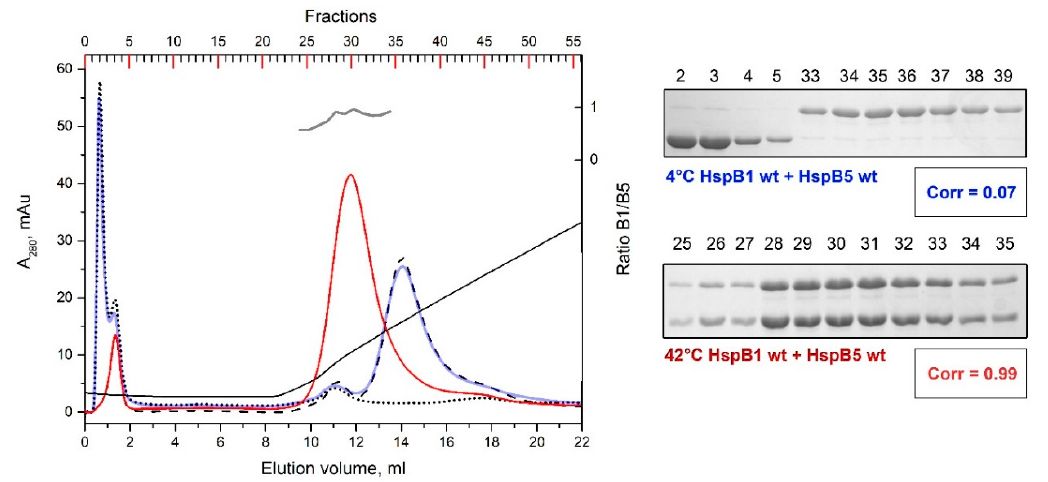
Figure 8. Ion-exchange chromatography of the WT HspB1 and HspB5. The elution profile of isolated HspB1 and HspB5 are shown as black dashed and dotted lines, respectively. The elution profile of the mixture of HspB1 and HspB5 preincubated at low temperature is shown as a solid blue line and that of the corresponding mixture preincubated at elevated temperature is shown as a solid red line. The molar ratio HspB1/HspB5 (grey solid line) in corresponding fractions obtained after chromatography of preheated sample is indicated on the right ordinate. Conductivity is shown as a solid black line. The protein compositions of fractions obtained after chromatography of HspB1/HspB5 mixture preincubated at low (labeled blue) or high (labeled red) temperature are presented on inserts. Correlation coefficient (Corr) is indicated under each electropherogram. The numbers above tracks correspond to the fractions number.